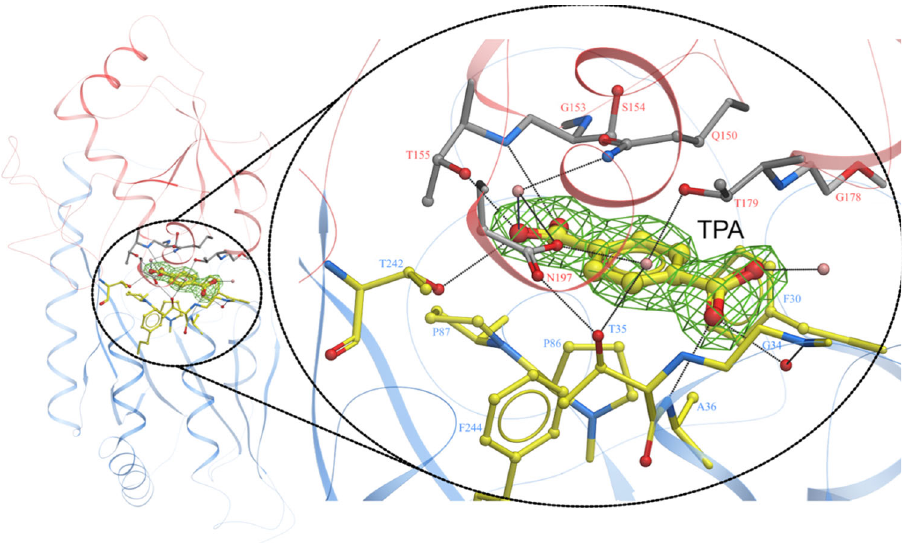
Fig. 5 TphC in complex with terephthalate. TphC crystal structure shown in ribbon representation and coloured by domain (domain 1 blue, domain 2 red). A close up of the bound TPA is shown in ball and stick representation (all atom colours) along with its associated 2.4 Å Fo − Fc omit electron density contoured at 2 σ . The binding pocket interactions are highlighted with residues arising from domain 1 shown in all atom colours (yellow carbon atoms) and domain 2 (grey carbon